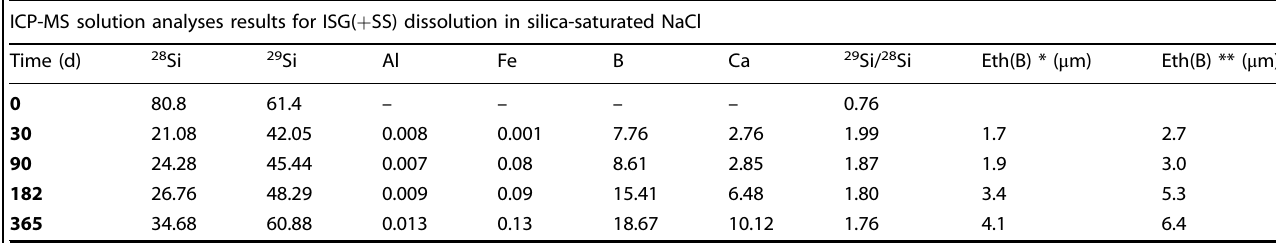
Table 2. Results of solution analyses for ISG-SS dissolution in silica-saturated NaCl. ICP-MS solution analyses results for ISG( + SS) dissolution in silica-saturated